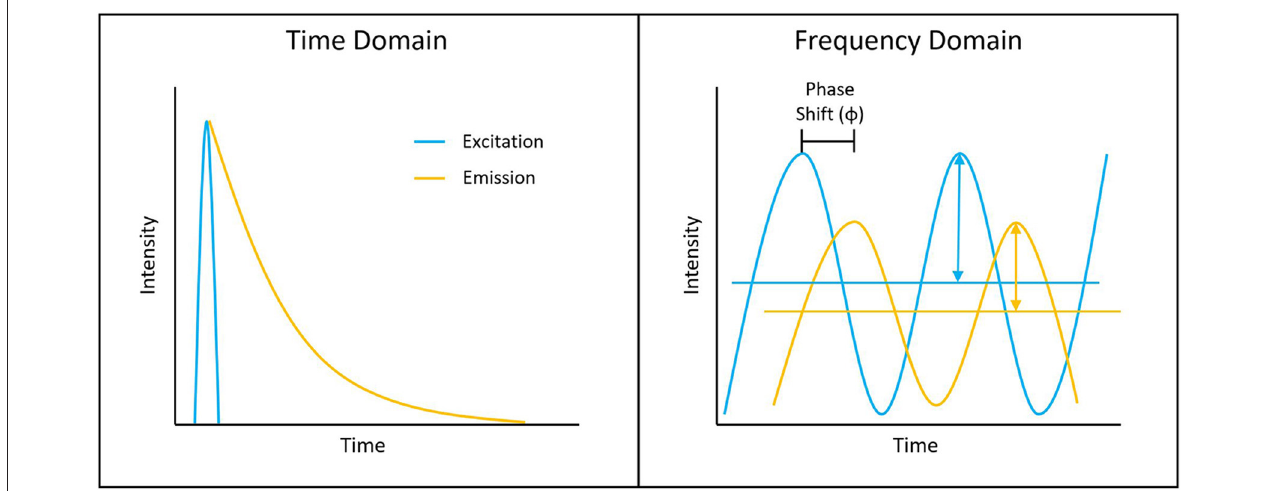
FIGURE 1 | Depiction of typical time-domain data (left) and frequency-domain data (right) . Lifetime determination in the time domain is a function of the decay curve created by a histogram of photon arrival times. For the frequency domain, the lifetime is a function of the phase shift between the laser excitation and fluorescence emission